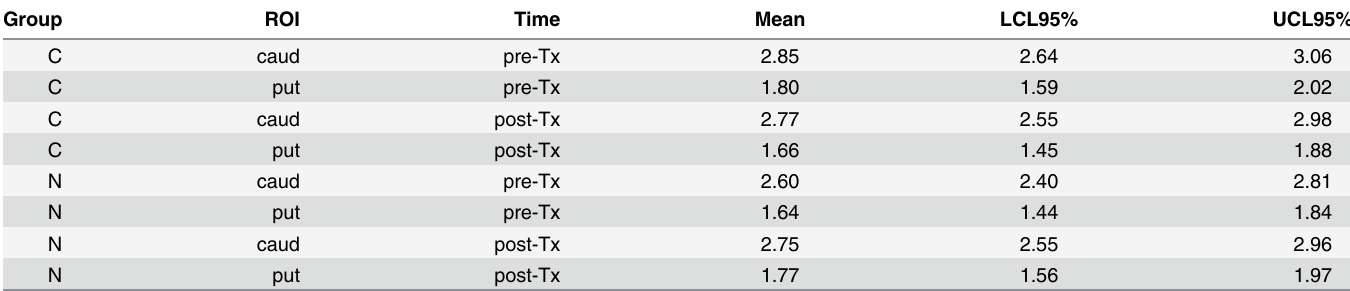
Table 2. Mean pre- and post-Tx dopamine transporter binding measures.